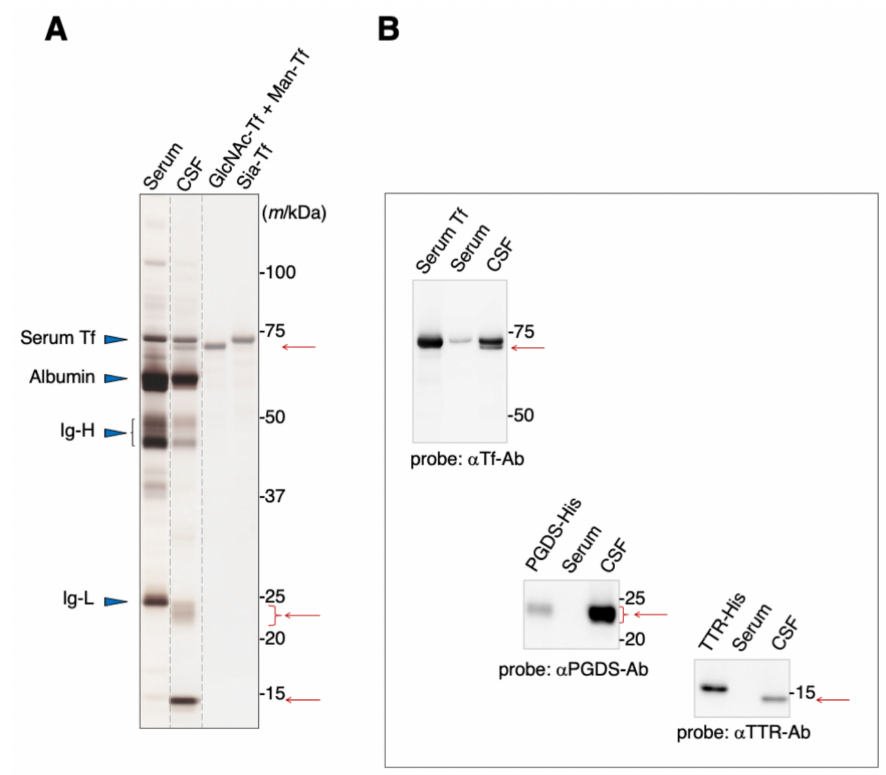
Figure 1. SDS-PAGE analysis of human serum and CSF ( A ). Protein bands were visualized by silver staining. Migration positions of major serum proteins such as serum Tf, albumin, and immunoglobu- lin heavy chain (Ig-H) and light chain (Ig-L) are indicated by blue triangles. Positions of additional major proteins in CSF are indicated by red arrows. Each lane separated on the gel is indicated by dotted lines. Purified standards of GlcNAc-Tf and Man-Tf were obtained from CSF as previously de- scribed, reprinted with permission from ref. [15], 2021 [15], Yasuhiro Hashimoto. The presence of TTR and L-PGDS, in addition to Man-Tf and GlcNAc-Tf, in the CSF was confirmed by immunoblotting using specific antibodies ( B ). Recombinant His-tagged TTR and L-PGDS show a mobility